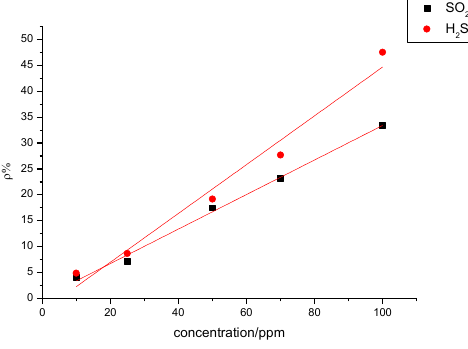
Figure 11. Linear relationship of MWNT sensor gas sensing response with different concentrations of SO and H 2 2